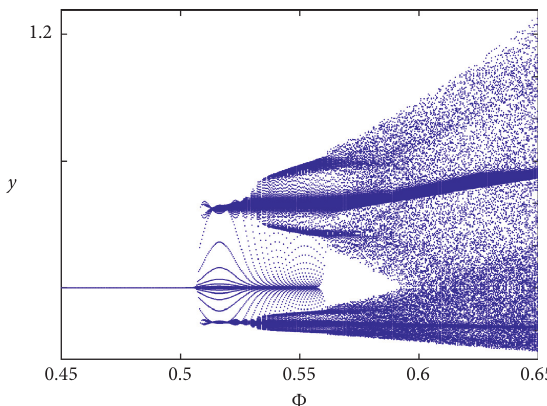
Figure 5: Detailed view of the grazing bifurcation.